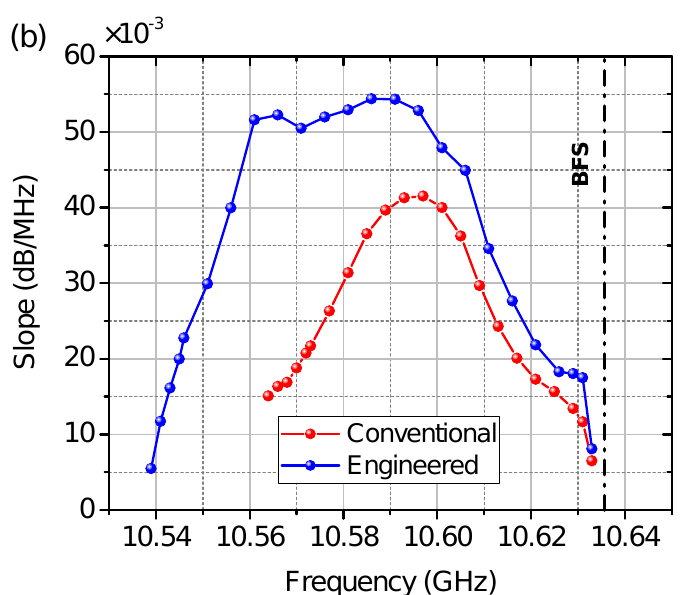
Figure 9. Experimental ( a ) conventional (red) and engineered (blue) BGS and ( b ) their slopes as a function of the interrogation frequency.